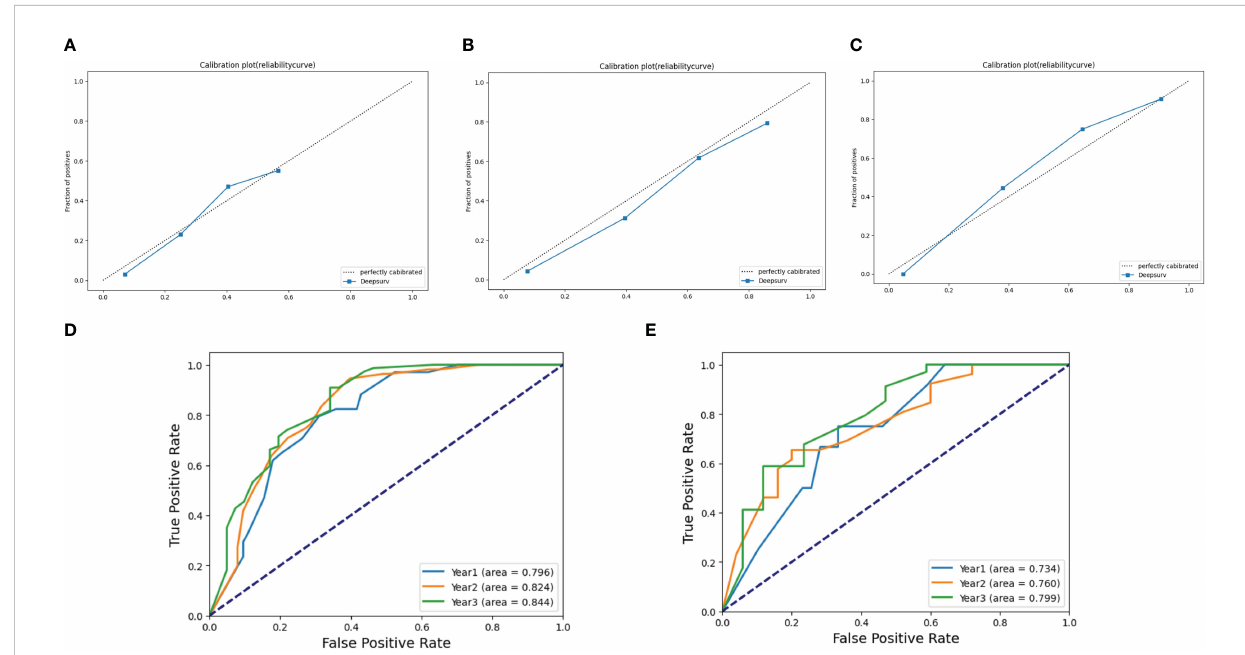
FIGURE 3 Calibration plots and ROC curve for the DeepSurv model. Calibration plots in (A) 1 year, (B) 2 years, and (C) 3 years in the training cohort. The ROC of 1, 2, and 3 years between the DeepSurv model in the training cohort (D) and the validation cohort (E) . ROC, receiver operating